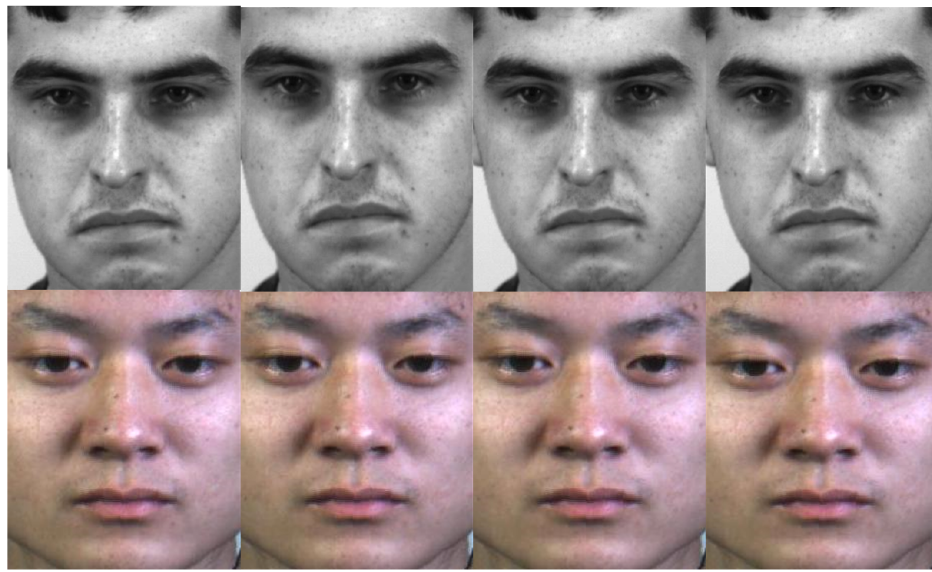
Figure 8. Partial ME samples. The above is SAMM-LV; below is CAS ( ME ) 2